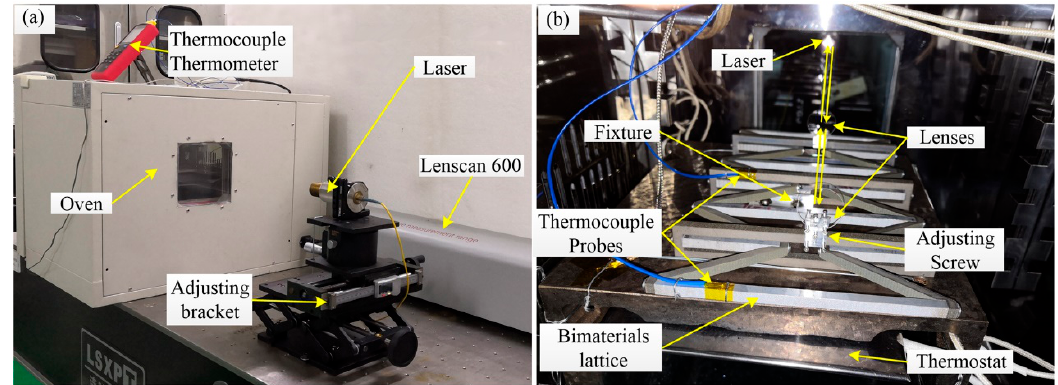
Figure 9. Experimental setup. ( a ) The overall diagram of the experimental apparatus, including Lenscan 600, laser, oven, adjusting bracket and thermocouple thermometer. ( b ) The experimental system inner the oven, including thermostat, thermocouple probes, bi-material lattice sample, two lenses, and adjusting the screw.